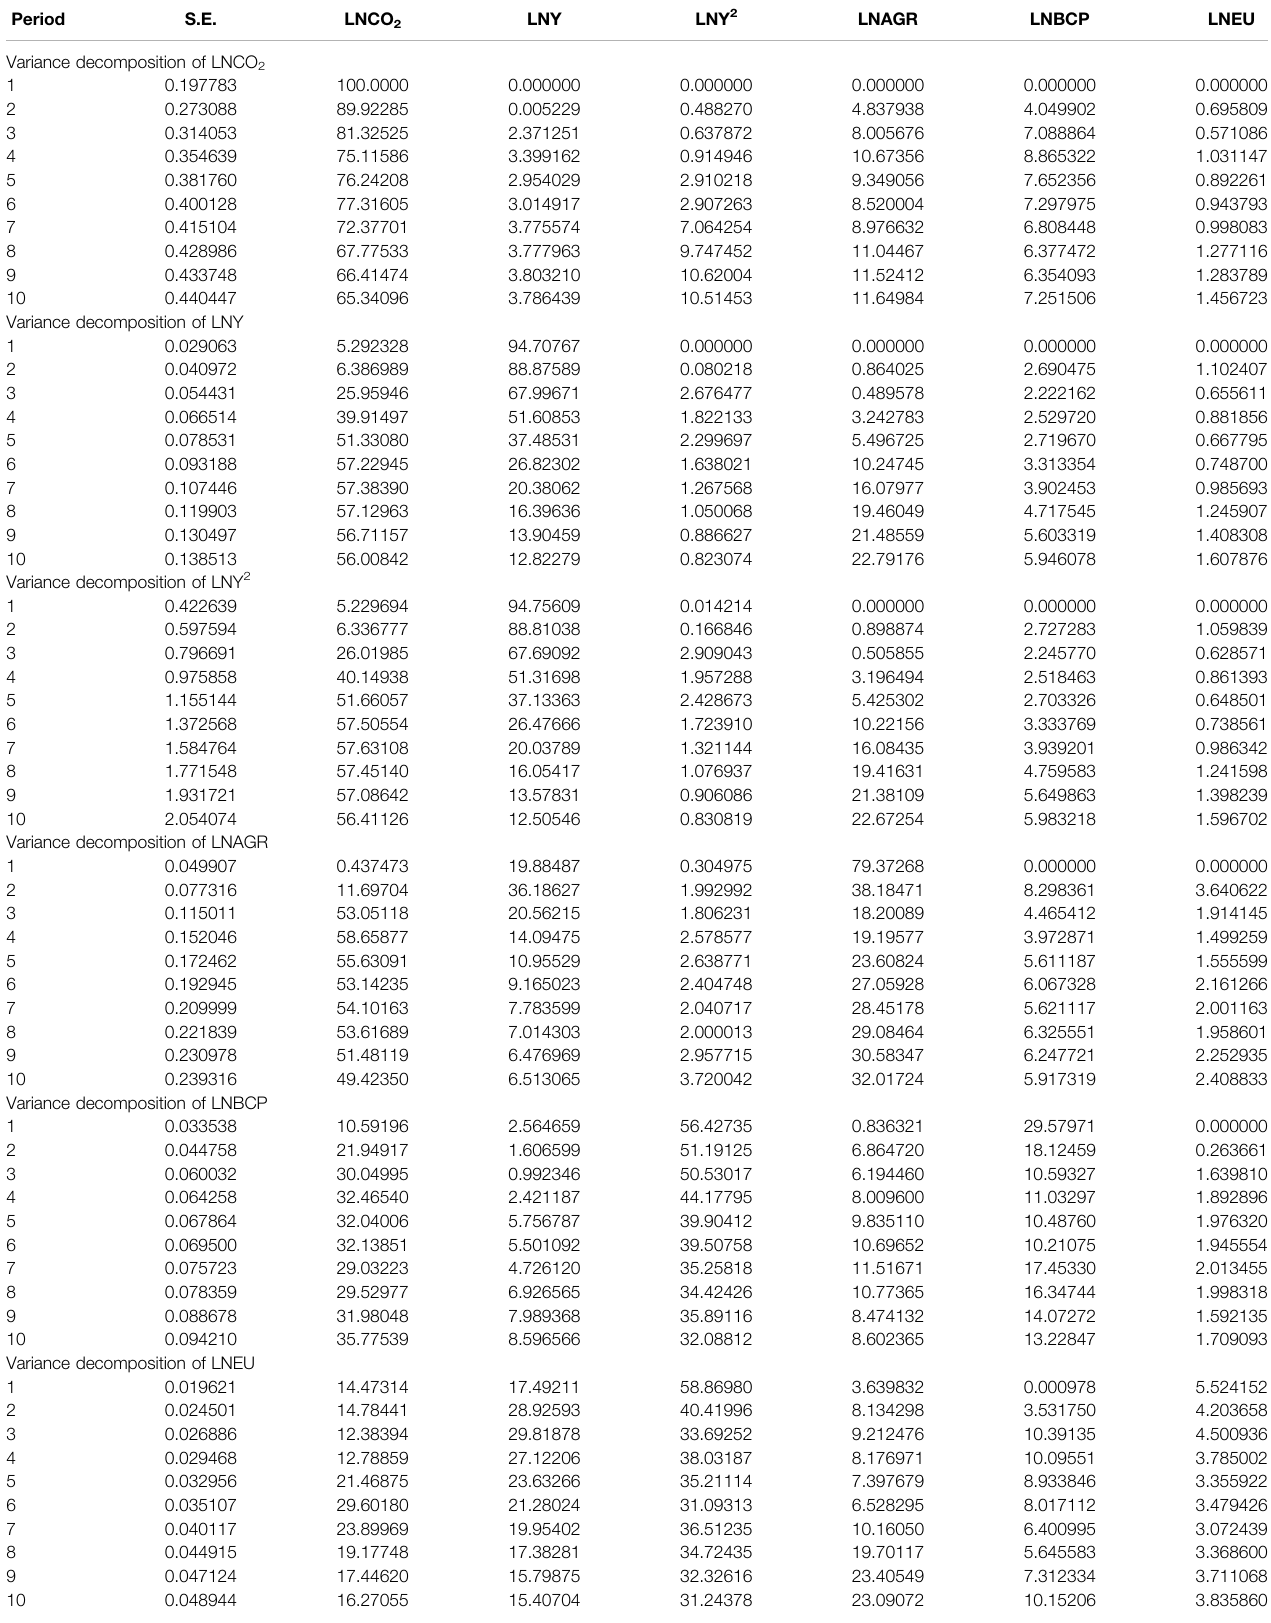
TABLE 8 | Forecast error variance decomposition.